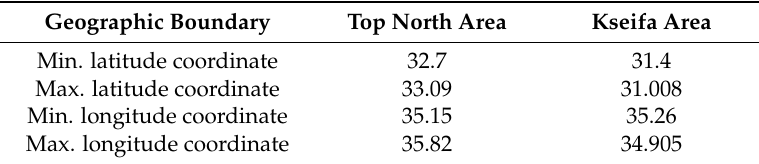
Table A3. The rural regions analyzed